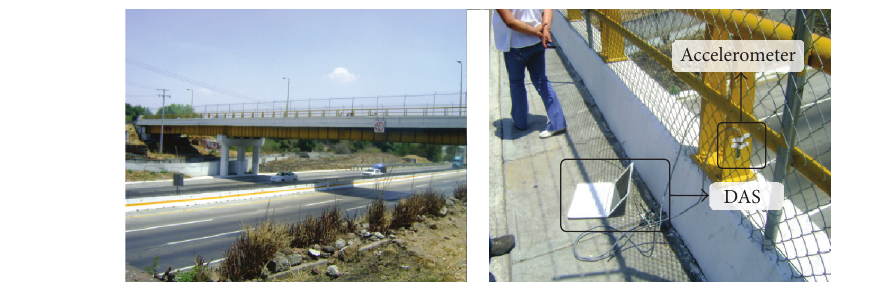
Figure 9: Analyzed